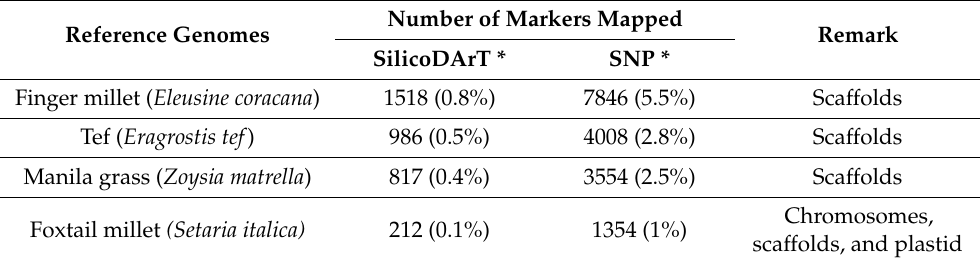
Table 1. Number of markers mapped onto the different reference genomes. Reference